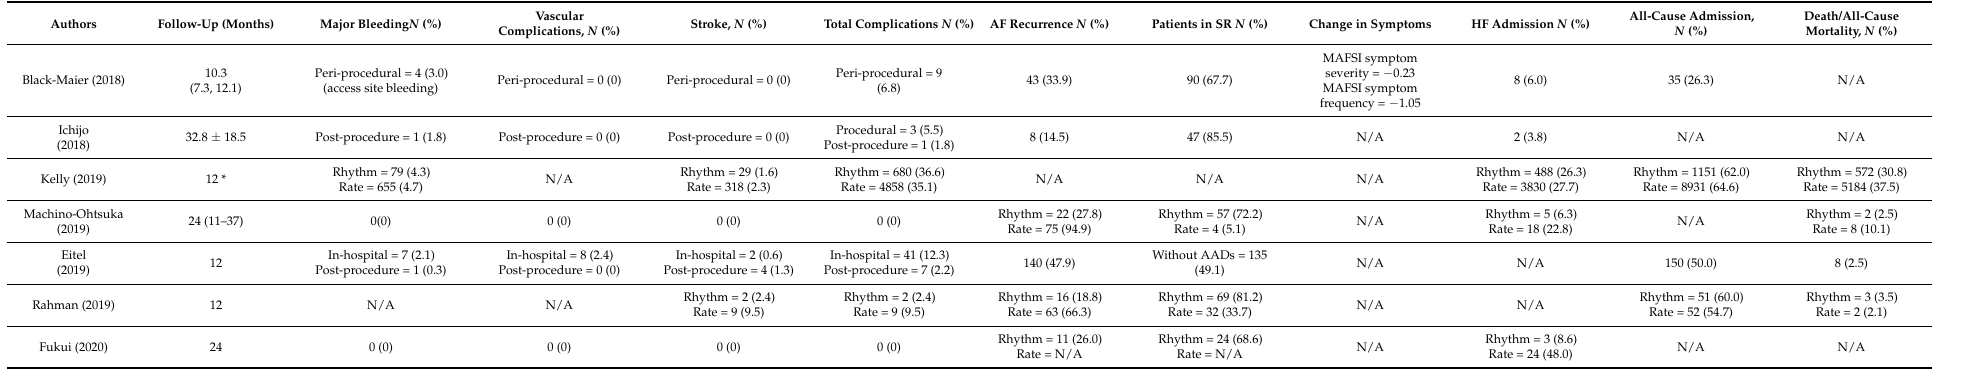
Table 3. Mortality and complication related outcomes of selected